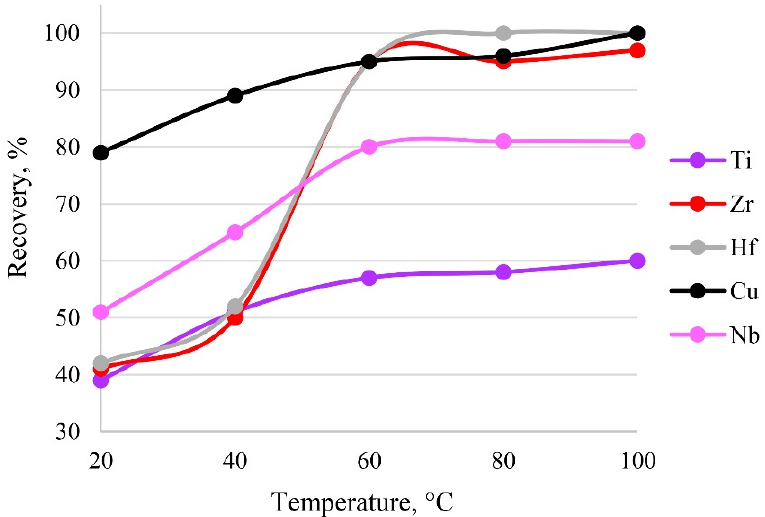
Figure 10. The dependence of recovery on temperature. Sorption conditions: 0.1 mol/L HCl, C EDTA/NH3 = 50/2500 mg/L, m PTE = 0.1 g, V liquid phase = 10 mL, t = 30 min, c analytes = 1 mg/L.